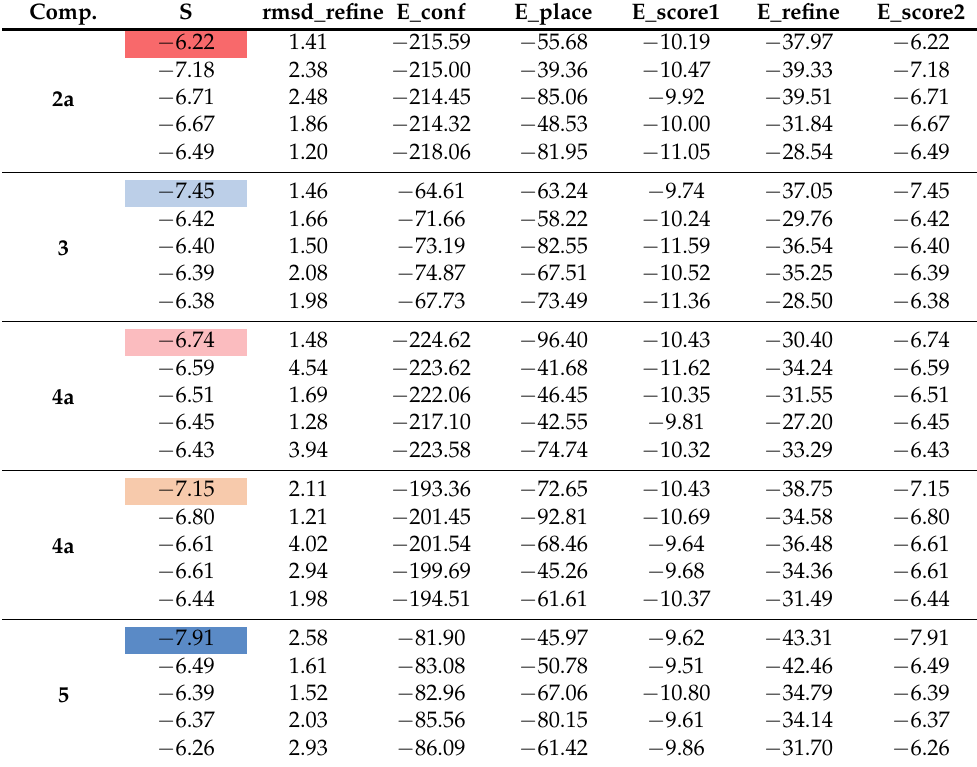
Table 4. Docking score and energies of all compounds with HeLa caspase “ 3 V266 ” protein. Comp.